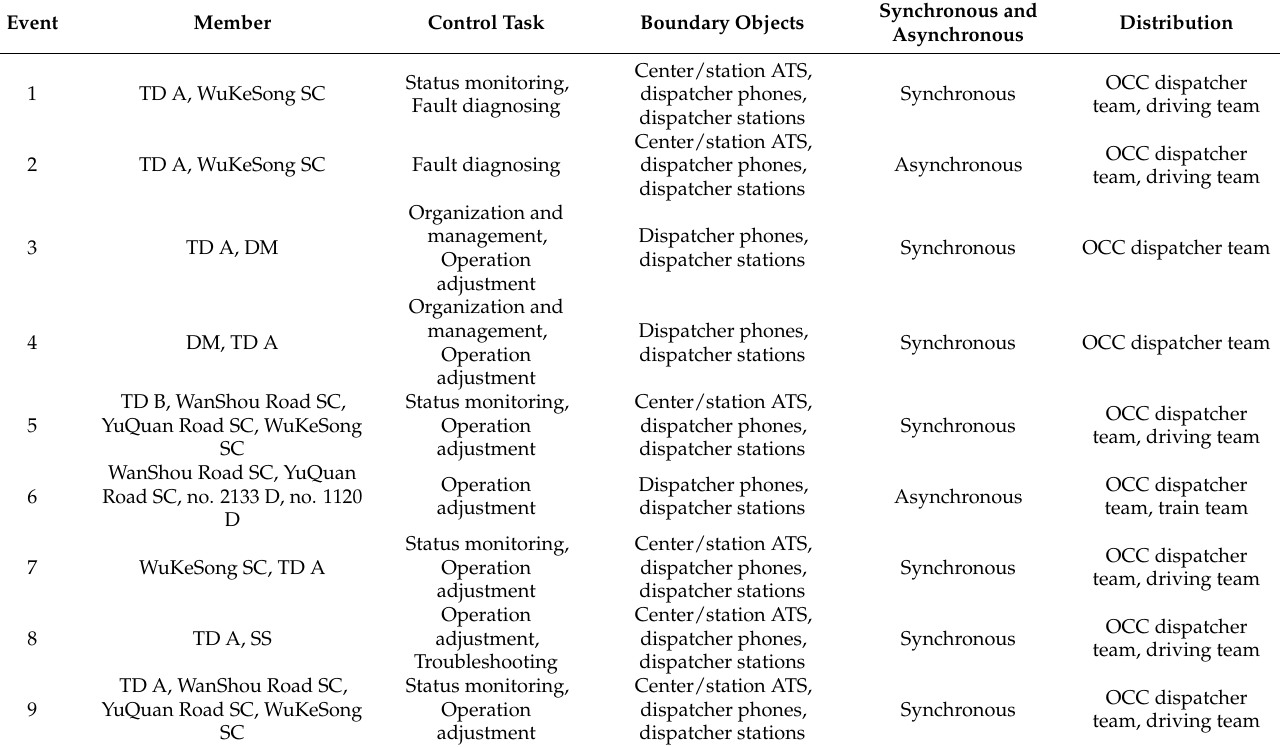
Table 2. Interaction analysis